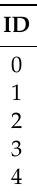
Table 5. Toy dataset with house ID and its location with missing house location